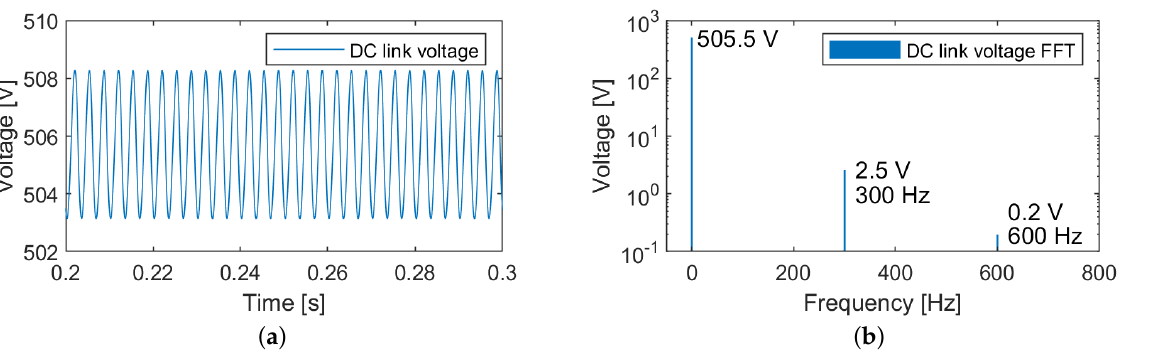
Figure 6. Passive rectifier simulation results. ( a ) DC link voltage. ( b ) DC link voltage harmonic analysis.